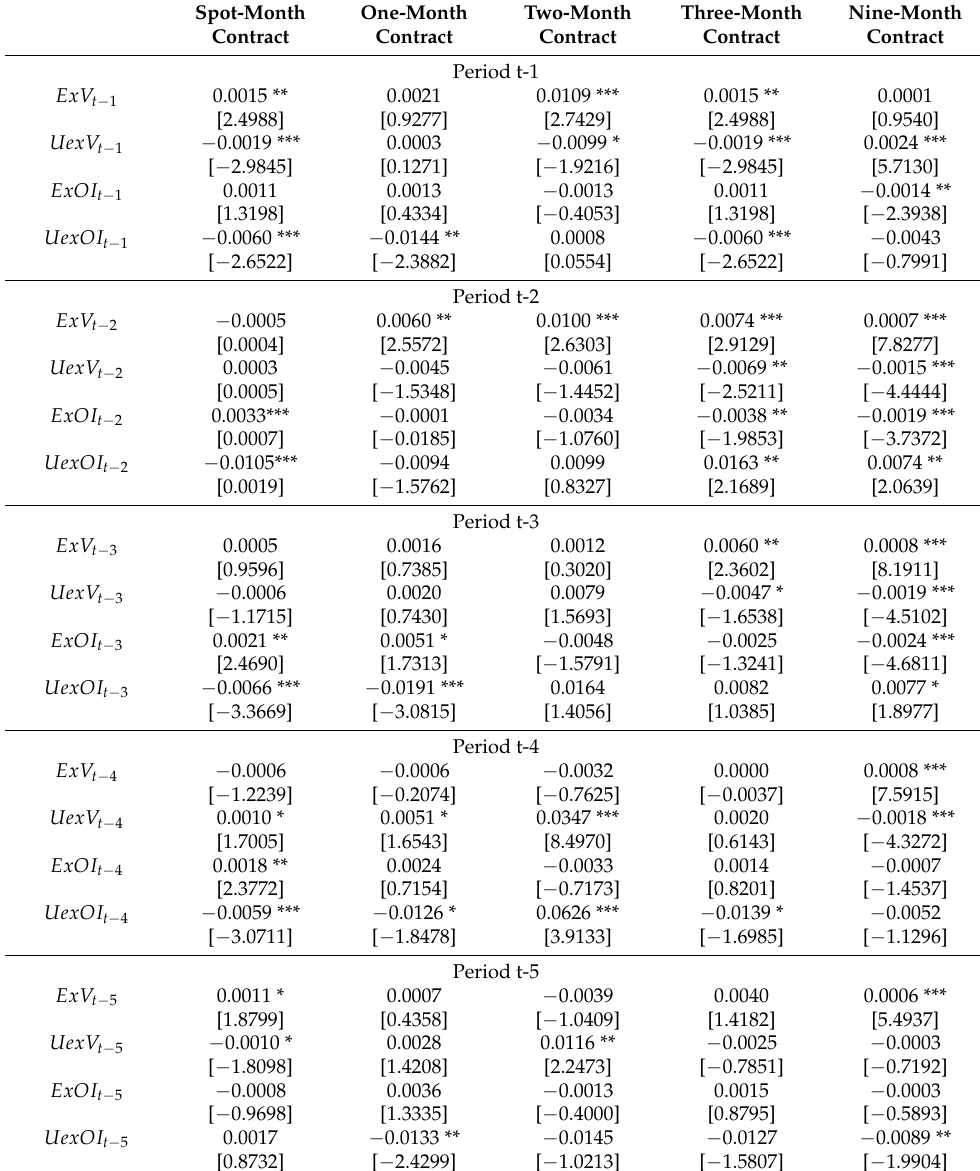
Table 6. Estimation Results of GARCH (1,1) for Malaysian Crude Palm Oil